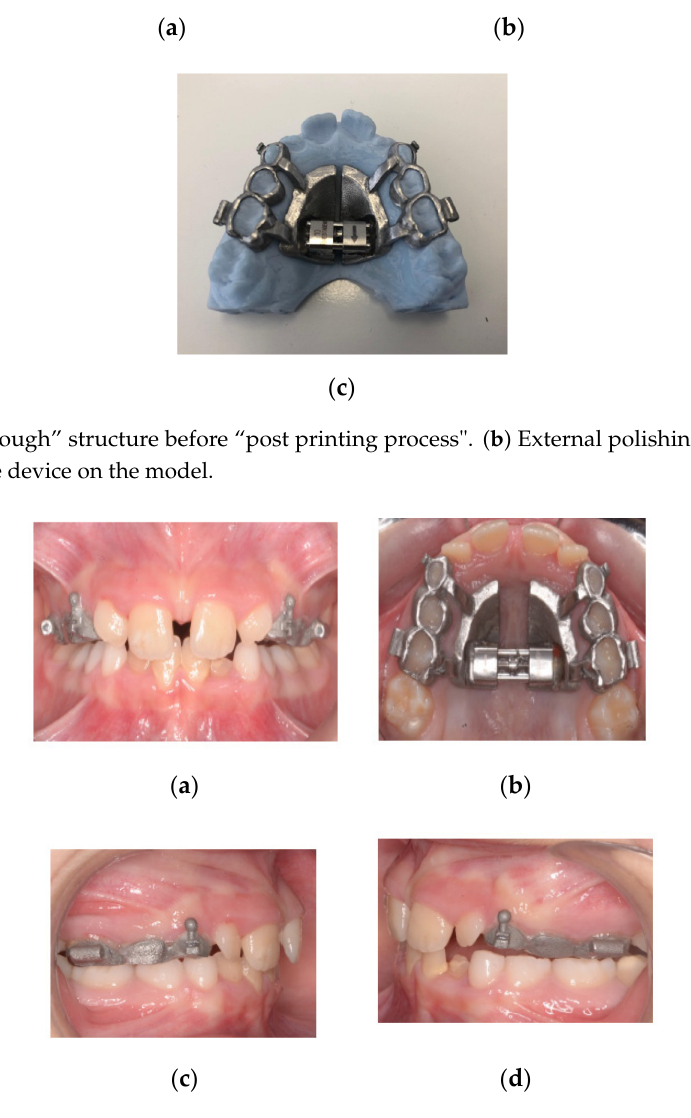
Figure 4. ( a ) Frontal photo of the patient after activating the expander. ( b ) Screw blocked with metal binding. ( c ) Right side photo. ( d ) Left side photo.